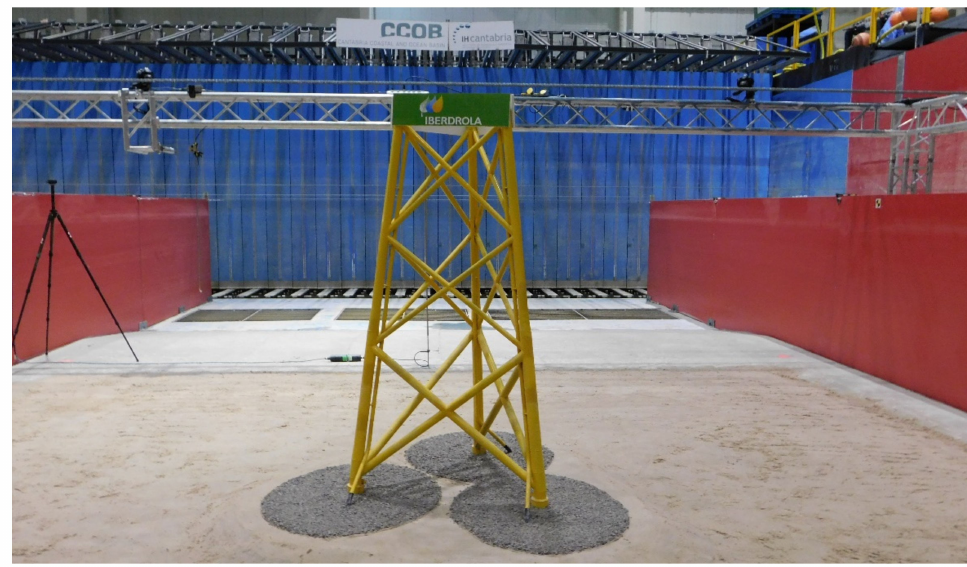
Figure 5. Mock-up.